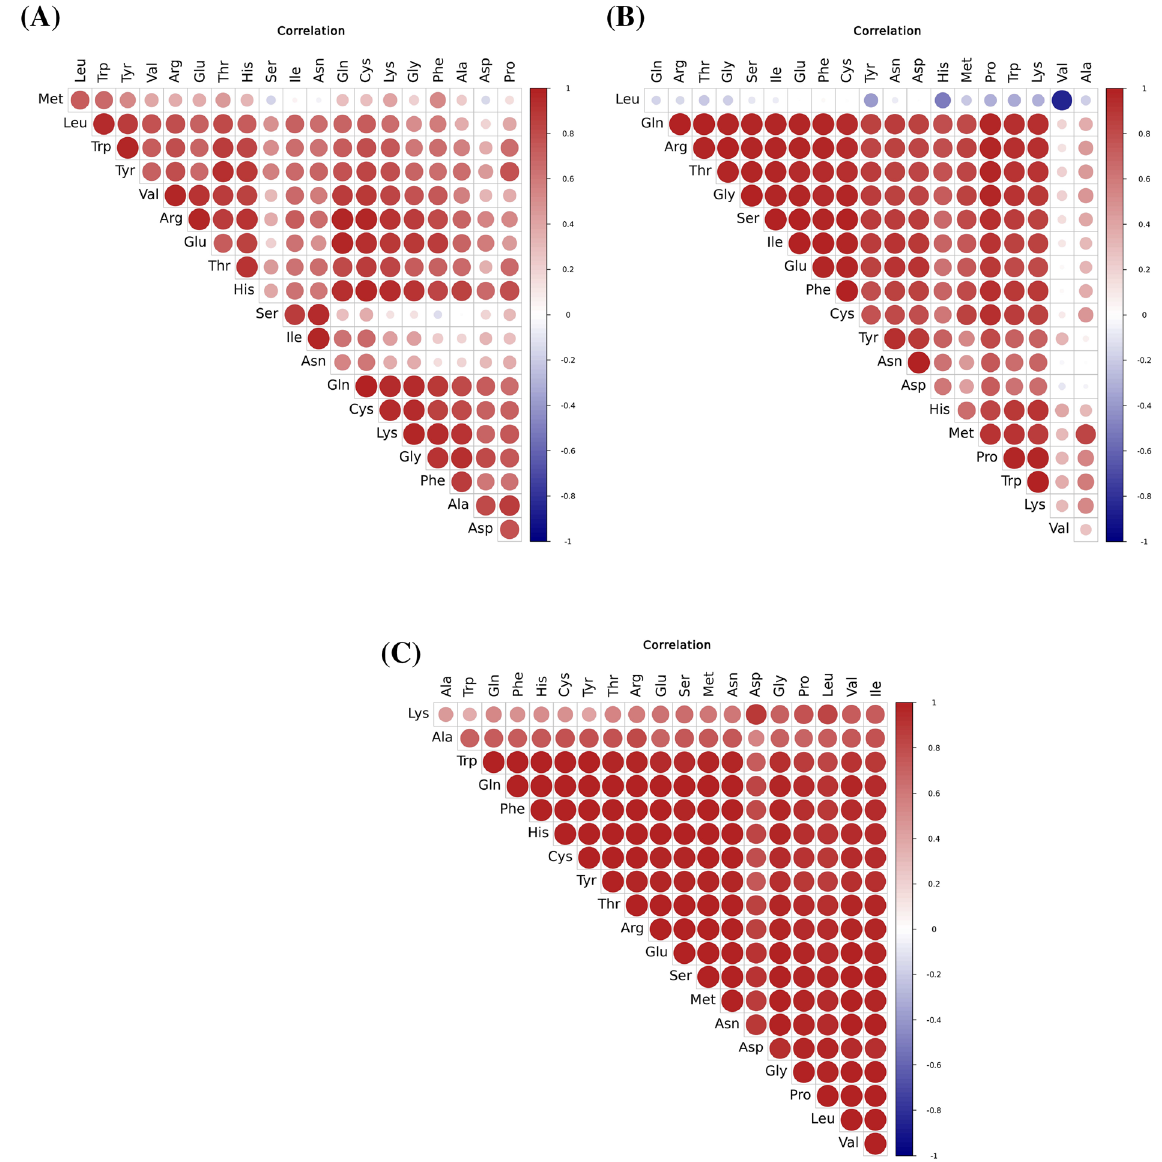
Figure 8. Correlation analysis of amino acids in AT ( A ), PT ( B ) and FT ( C ). Alcalase-treated cow milk (AT), Protamex-treated cow milk (PT), Flavourzyme-treated cow milk